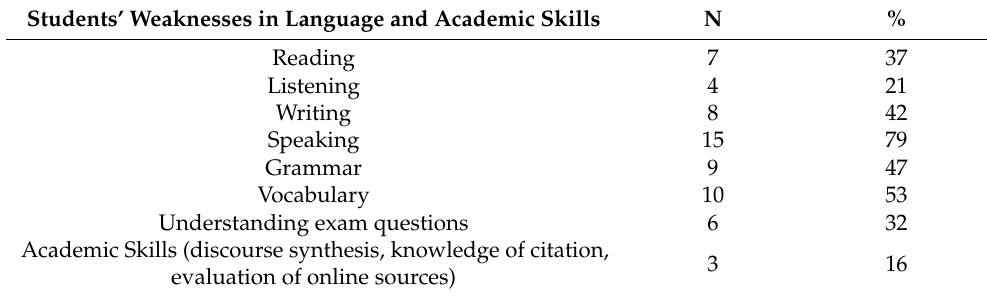
Table 4. Teacher perceptions of students’ weaknesses in language and academic